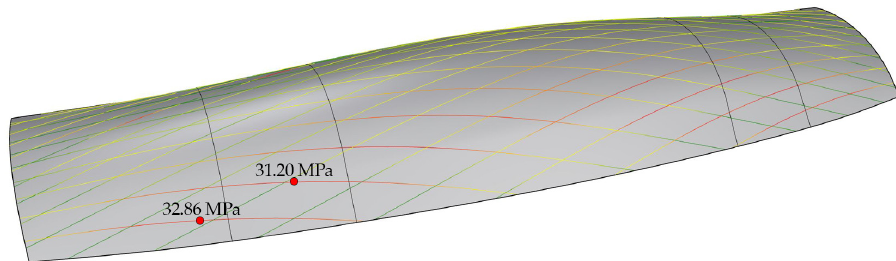
Figure 24. Final selected solution.